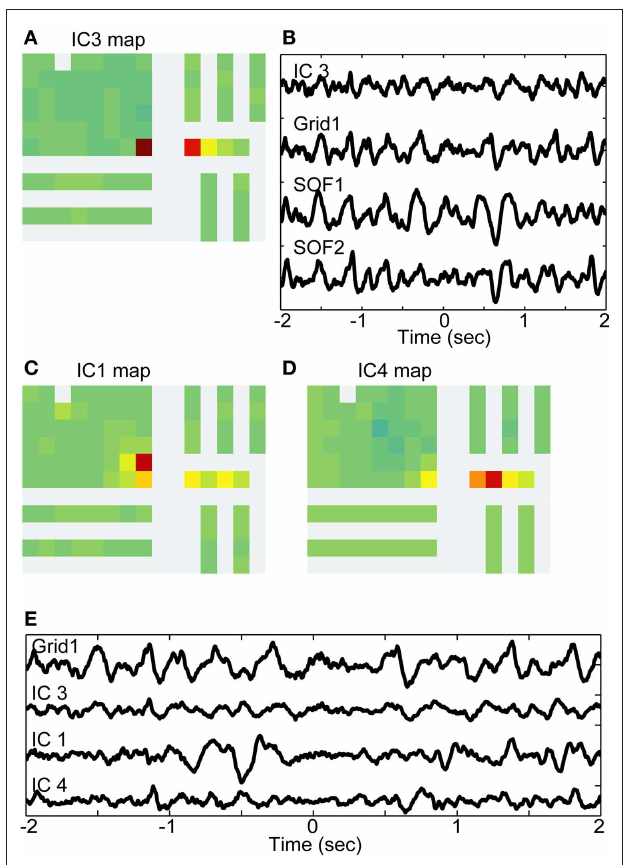
FIGurE 7 | Multiple independent components associate lateral and medial frontal channels with interictal delta activity. (A) Map from independent component 3 (IC3) projecting to Grid1 and to two adjacent channels from the superior orbital frontal strip: SOF1 and SOF2. (B) Example 2-s time series from IC3 and the three channels to which it projects in varying degrees. (C) Map of IC1 projecting most strongly to Grid9 (red-colored electrode), but also to Grid1, SOF1, SOF3, and Grid10. (D) Map of IC4 projecting most strongly to SOF2 (red), but also SOF1 (orange), Grid1 (yellow), and SOF2 (yellow). (E) Example 2-s time series from Grid 1 and thethree independent components with maps shown in A, C, and D.